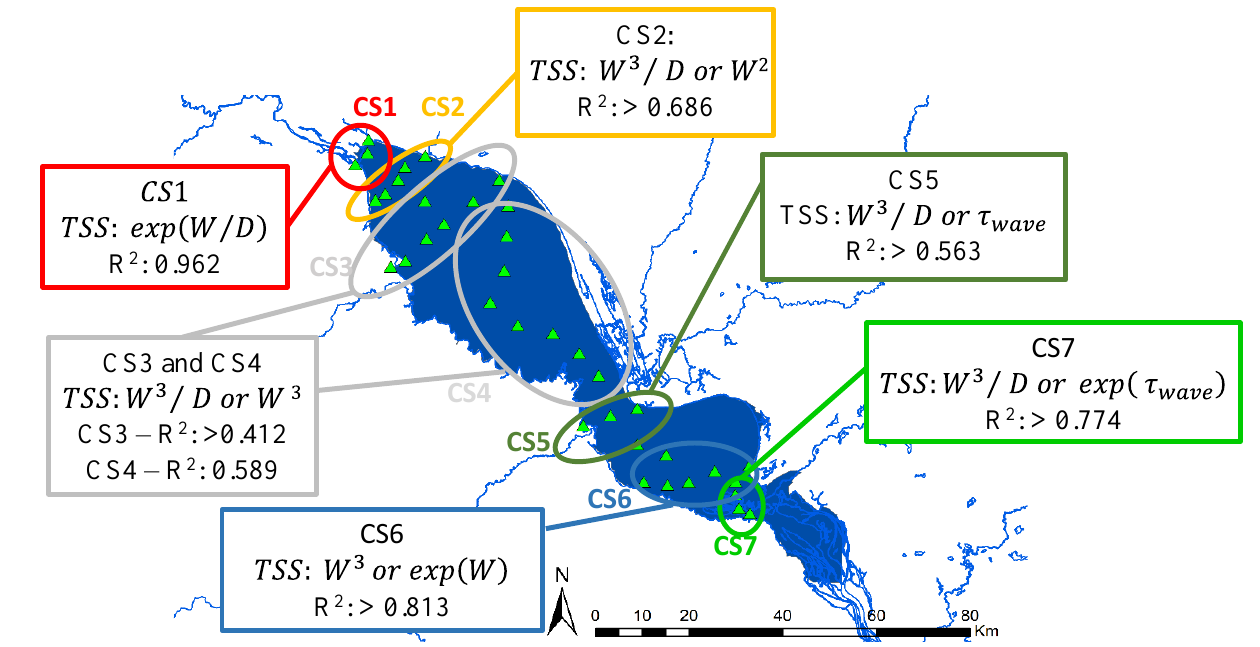
Figure 4. Empirical relation of TSS with the wind speed and lake depth across various cross sections (CS) in Tonle Sap Lake, Cambodia ( W = wind speed, D = water depth, and 𝜏 𝑤𝑎𝑣𝑒 = shear stress; for details, please refer to Table 4).